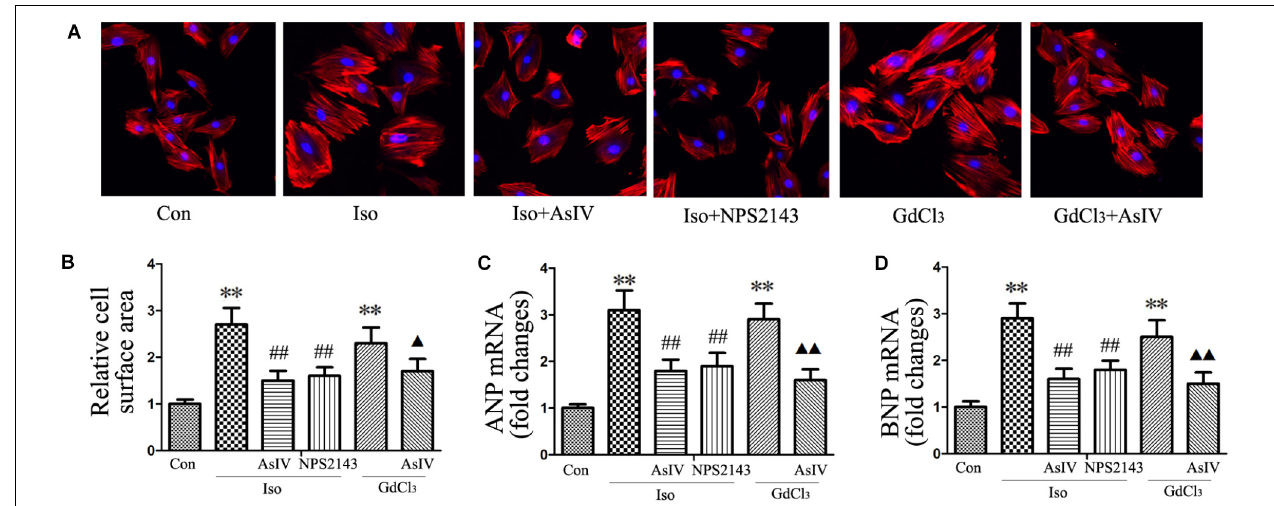
FIGURE 1 | AsIV inhibited H9C2 cell hypertrophy induced by Iso or GdCl 3 . (A) H9C2 cells were stained with rhodamine-labeled phalloidin and DAPI and then examined and photographed using a fluorescence microscope (magnification × 200). (B) Cell surface area was measured and analyzed with LAS Software (V4.3) (Leica, Germany). The bars represent the cellular size relative to that of the controls. (C,D) mRNA expression of ANP and BNP. The data are expressed as the means ± SEM, n = 4. ∗∗ P < 0.01 vs. the Con group; ## P < 0.01 vs. the Iso group; and (cid:78) P < 0.05, (cid:78)(cid:78) P < 0.01 vs. the GdCl 3 group.